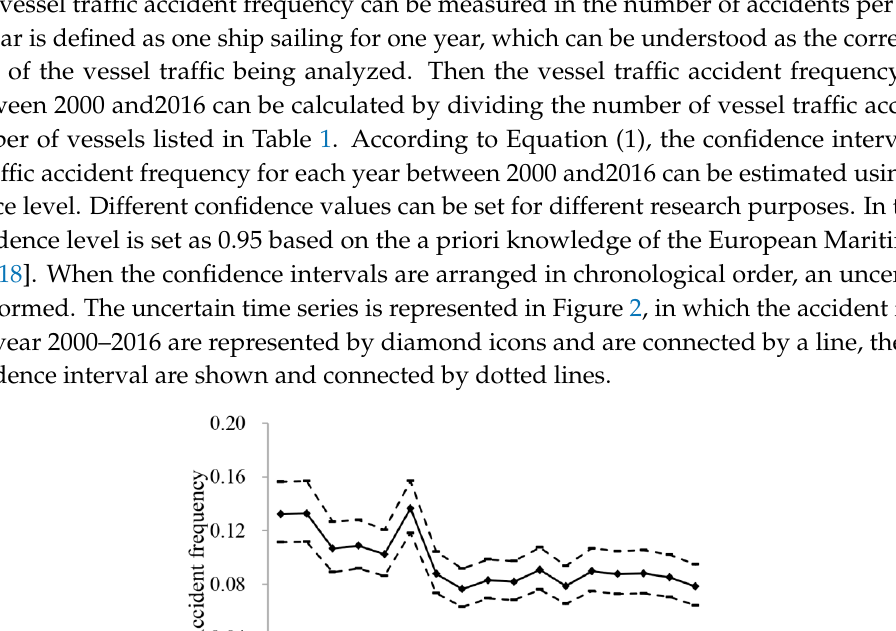
Table 1. Vessel traffic accident data.